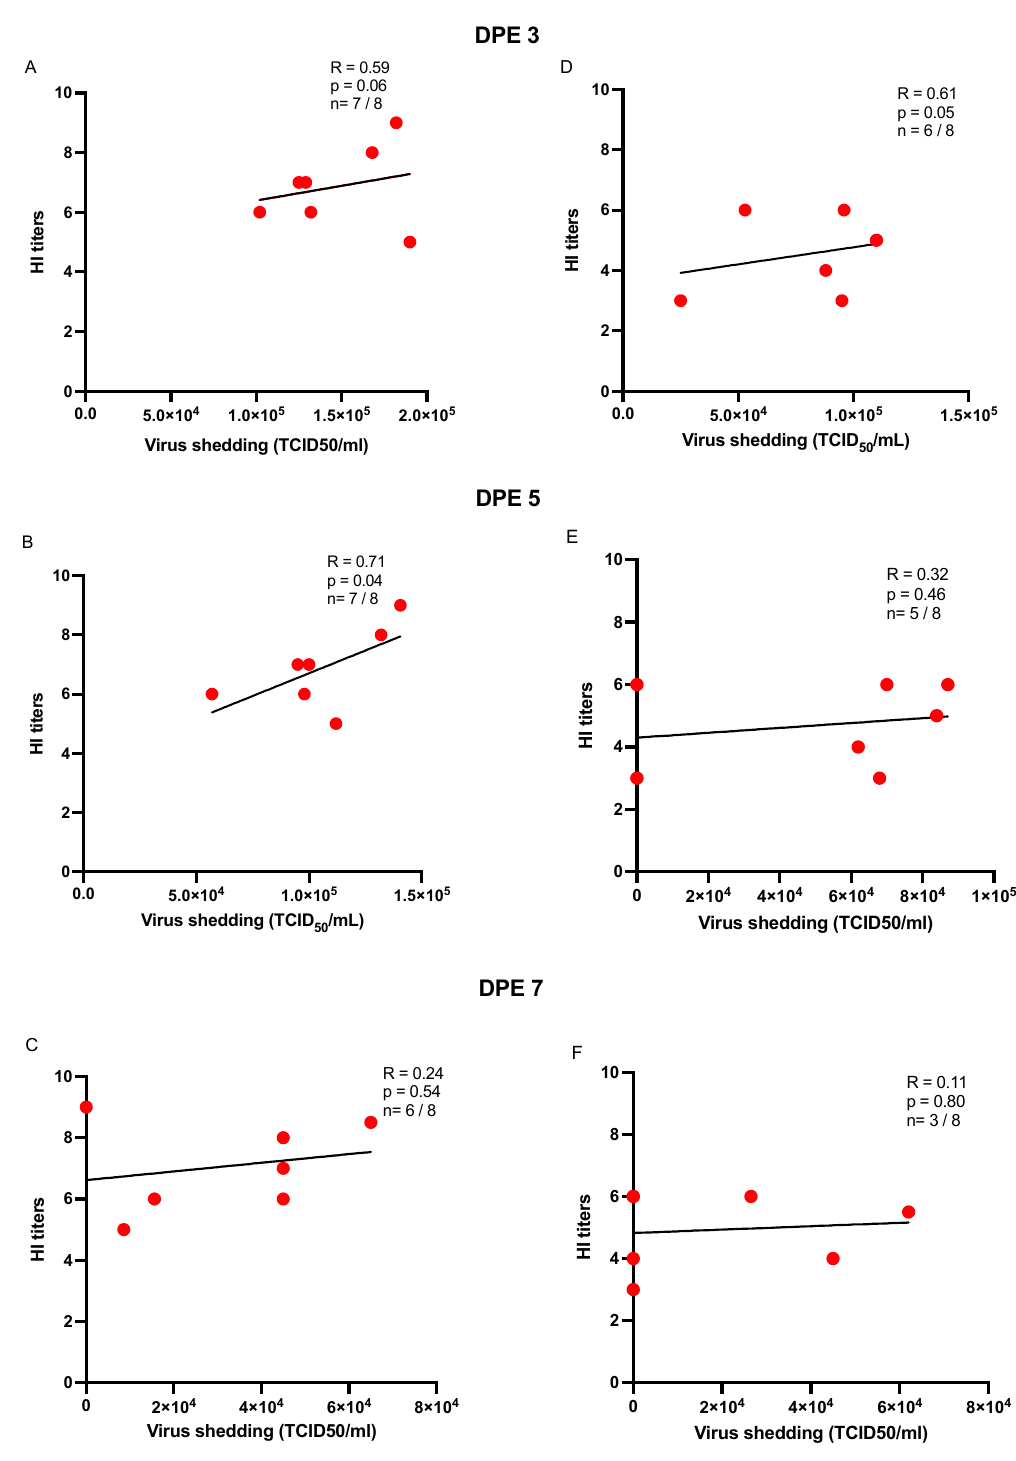
Figure 6. ( A – F ) Scatter plots illustrating the correlation of HI antibody titers and cloacal virus shedding in exposed recipient chickens (expressed as TCID50/mL). Spearman’s correlation (R) was determined between cloacal virus shedding on days 3, 5, and 7 post-exposure (PE) with the HI titers (day 14 PE) in the H9N2-AIV-infected recipient chickens (n) of the aerosol ( A – C ) and direct inoculation ( D – F ) groups. The data points on the graph represent individual chickens that were deemed positive using TCID 50 assay (out of the total recipient chickens) at the above-mentioned time points of swab collection. Data were considered significant when * p < 0.05.